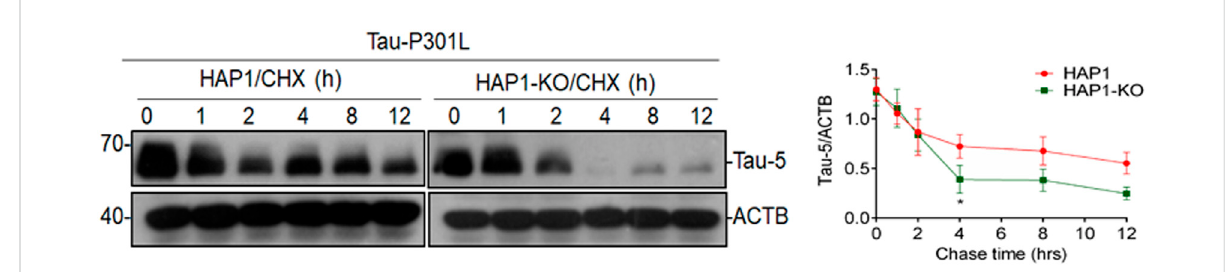
FIGURE 4 Effect of KIF5B knockout on the protein stability of Tau-P301L Tau mutant. HAP1-WT or HAP1-KO cells were transfected with Tau-P301L plasmidovernightfollowedbytheadditionofcycloheximide tostopnewproteinsynthesisandchasedforindicatedtimes.Celllysatesfromdifferent timepointsandanalyzedbyimmunoblottingwithTau-5andACTBantibodies.GraphicalrepresentationofHAP1-WTandHAP1-KOtransfectedTau- P301L plasmid with cycloheximide chasing experiment. The levels of Tau-5 was quanti fi ed from each timepoint and the data were represented as mean ± SEM of three independent experiments. * p < 0.05 signi fi cantly different from HAP-WT transfected cells.